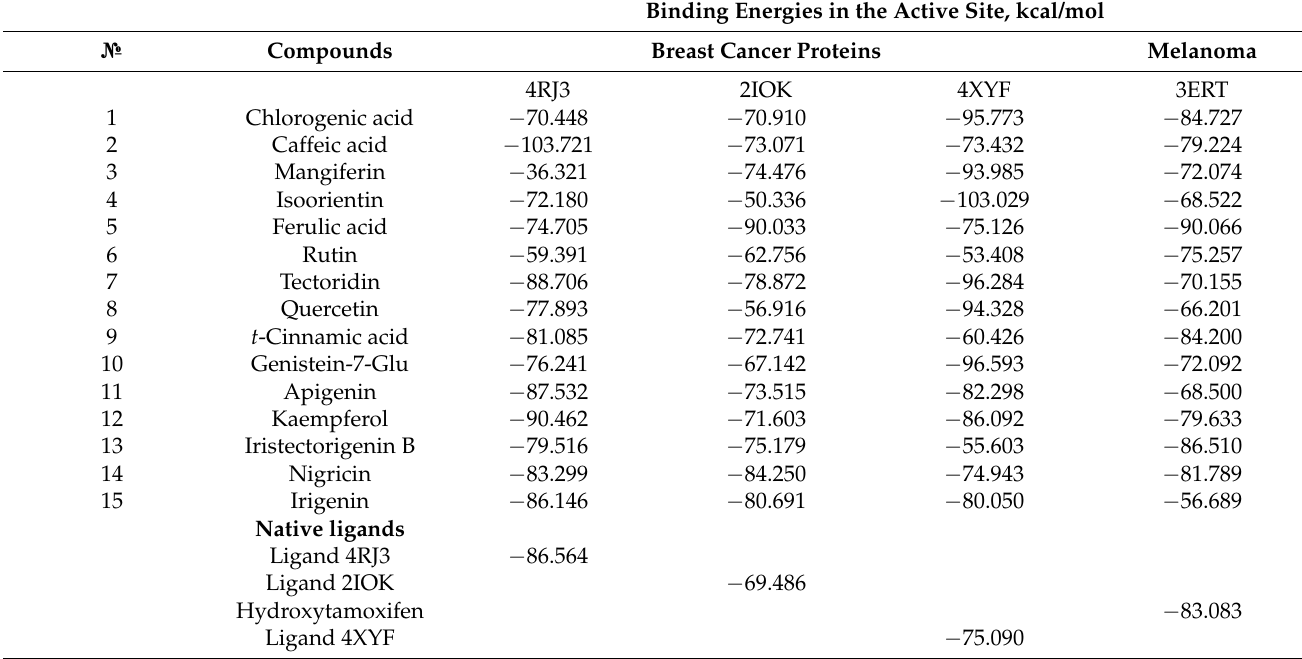
Table 3. Binding energies of the selected compounds identified from C. sativus leaf extracts docked against the target protein